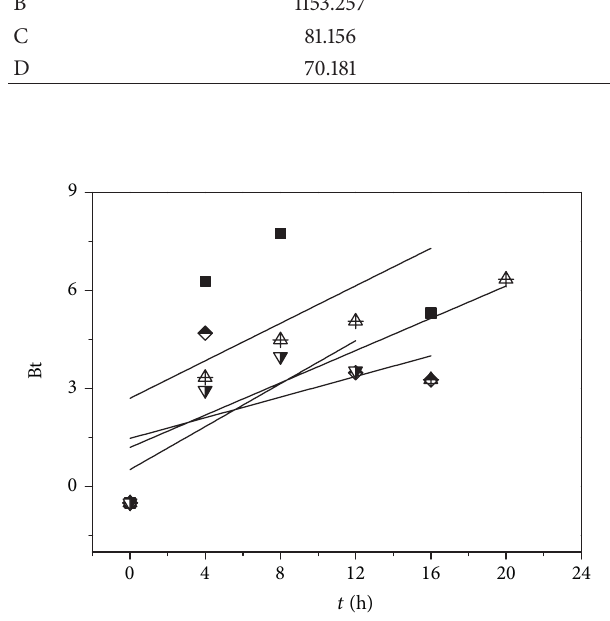
Figure 6: The plot of Boyd model for the adsorption of strontium ions on samples A (solid square), B (half-filled diamond), C (center up triangle), and D (half-filled down